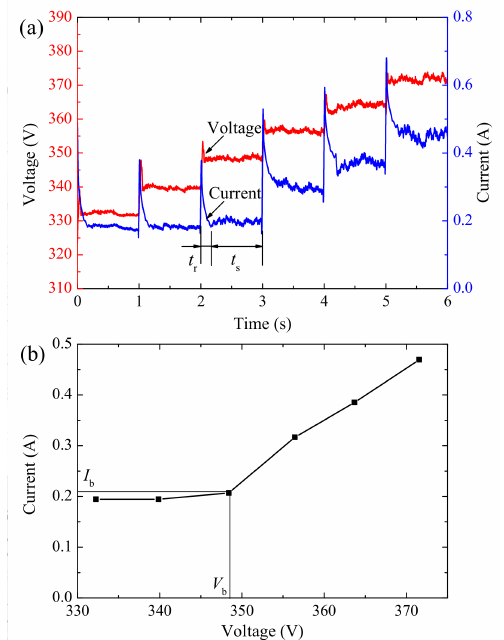
Figure 2. ( a ) Partial voltage and current waveforms during pre-treatment process with voltage sweep at 8 V / s and ( b ) their voltage-current characteristic